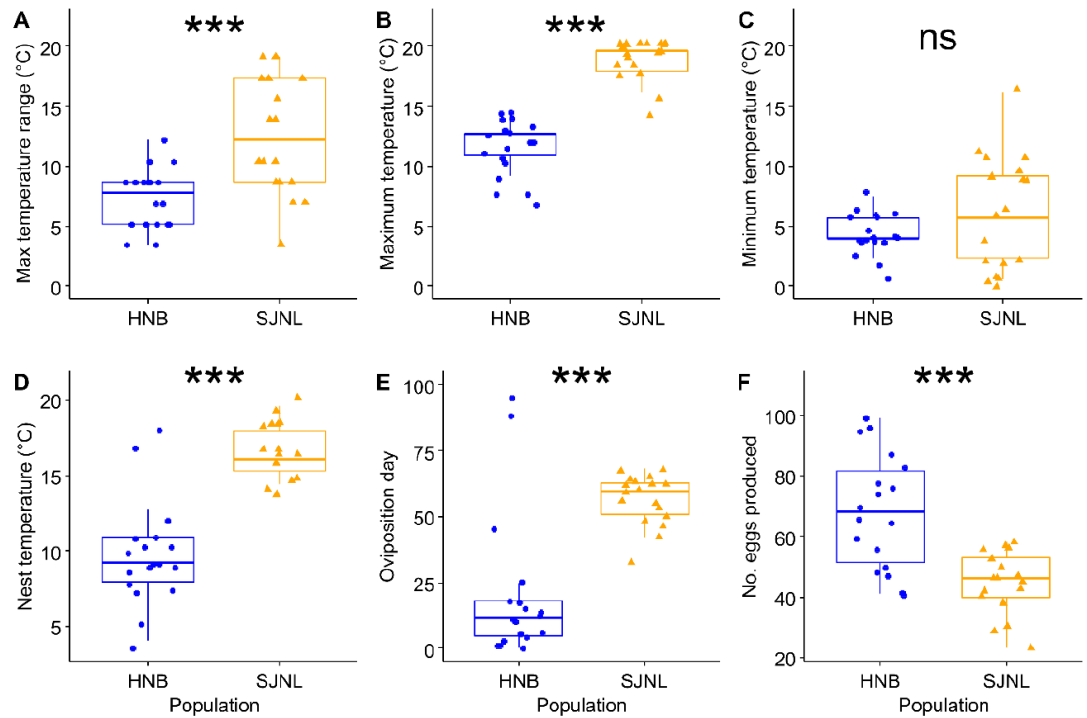
Figure 3 – Effect of population on location and reproduction until oviposition. (A) Maximum temperature range, (B) warmest and (C) coldest location at which females were observed during the 15 days preceding oviposition. (D) Location and (E) day at which females laid eggs, and (F) number of eggs produced. Box plots depict median (middle bar) and interquartile range (light bar), with whiskers extending to 1.5 times the interquartile range and dots representing jittered experimental